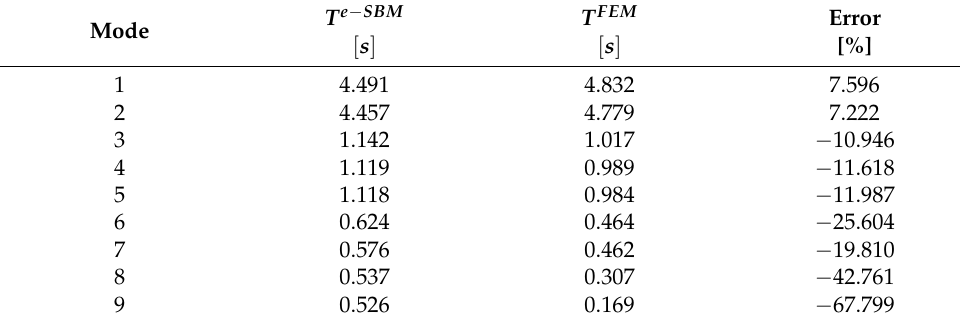
Table 2. Natural periods between the e-SBM and FE